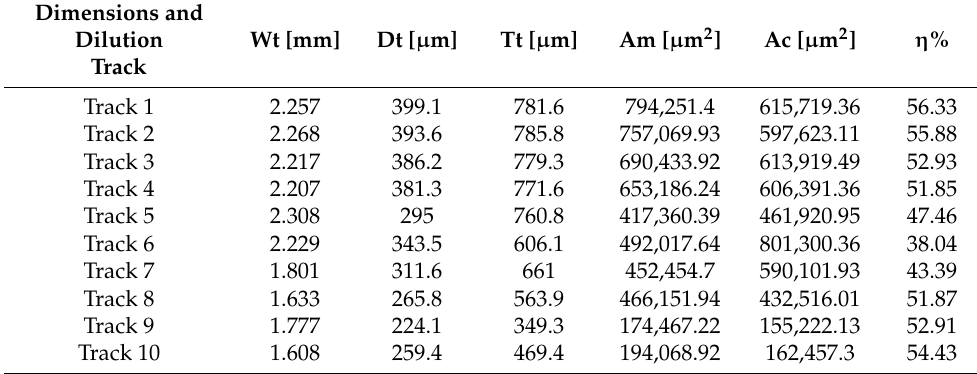
Table 3. Cladding track dimensions and dilution